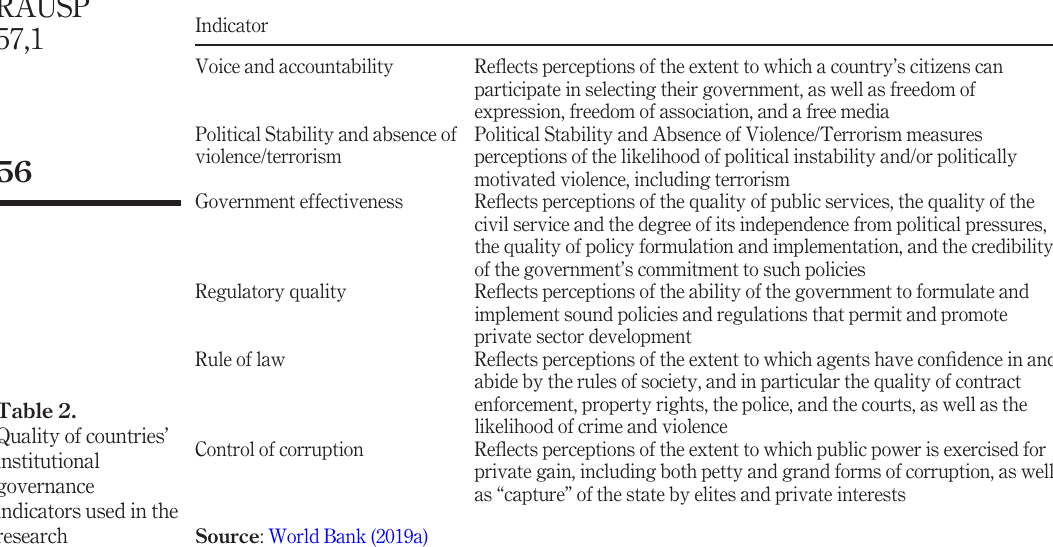
Table 2. Quality of countries ’ institutional governance indicators used in the